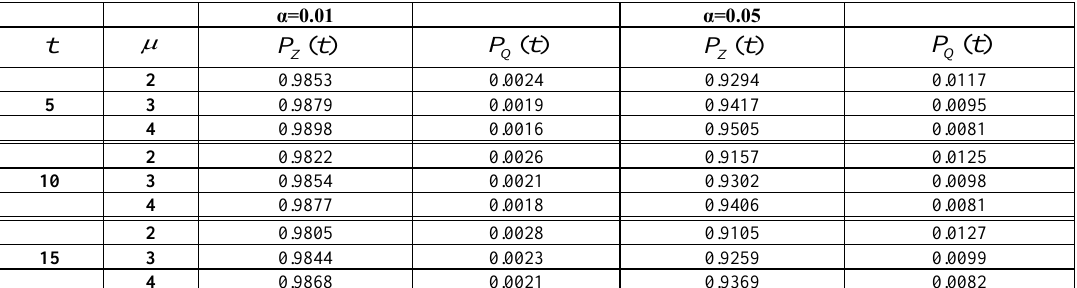
Table 1. Effect of α on state